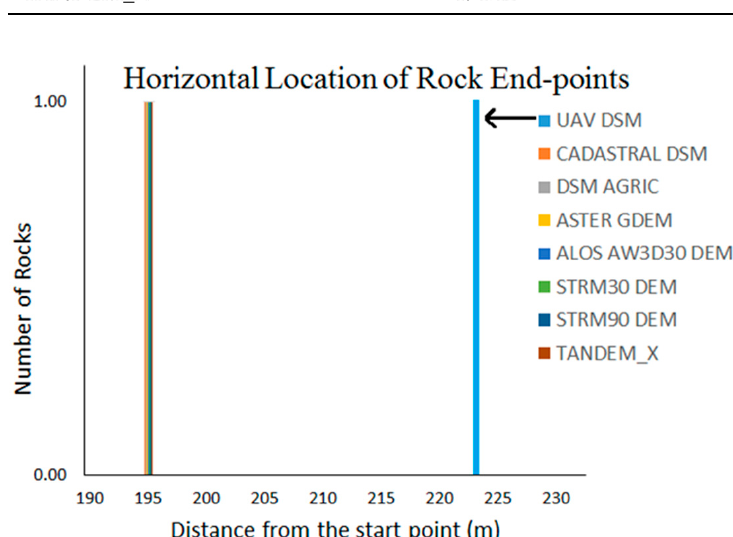
Figure 20. Horizontal location of rock end points for the 2nd slope profile from all the DSMs.